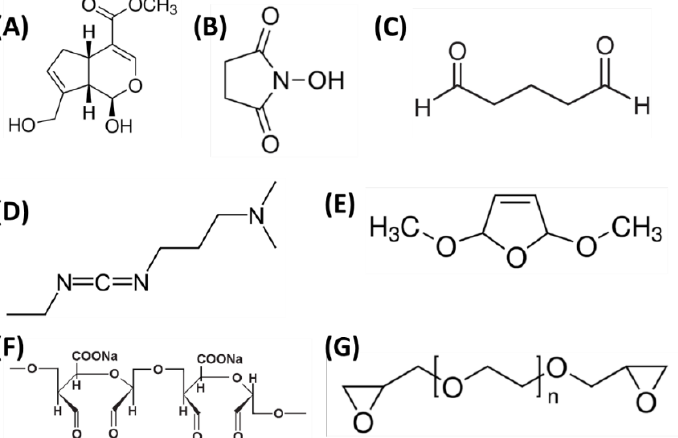
Figure 6. Agents used to chitosan/silk fibroin mixtures cross-linking: ( A ) genipin; ( B ) N-hydroxy- succinimide (NHS); ( C ) glutaraldehyde; ( D ) 1-Ethyl-3-(3-dimethylaminopropyl) carbodiimide hy- drochloride (EDC); ( E ) 2,5-Dihydro-2,5-dimethoxyfuran (DMDF); ( F ) alginate dialdehyde (ADA); and ( G ) polyethylene glycol diglycidyl ether (PEGDE).